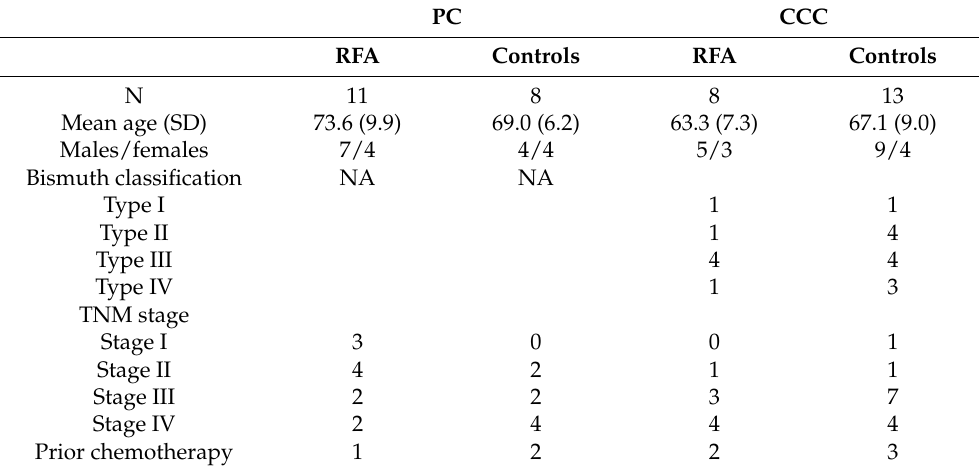
Table 3. Characteristics of the study